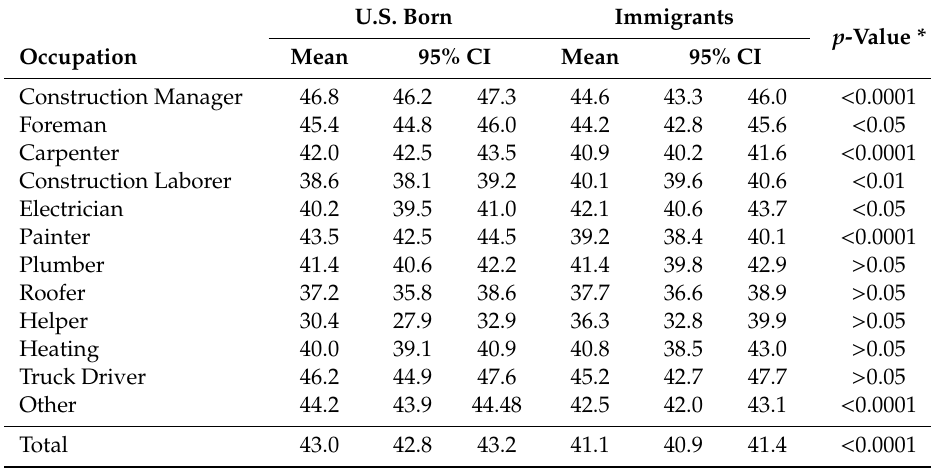
Table 1. Average age of construction workers by occupation, U.S. born versus immigrant worker, average of 2015–2017 (All employment).